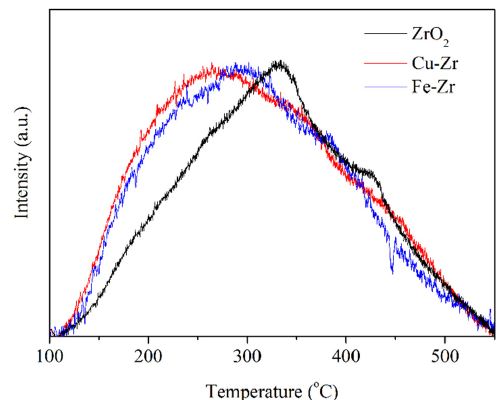
Figure 2. Temperature-programmed desorption of NH 3 (NH 3 -TPD) profiles of ZrO 2 support, Cu-Zr and Fe-Zr calcined catalysts.